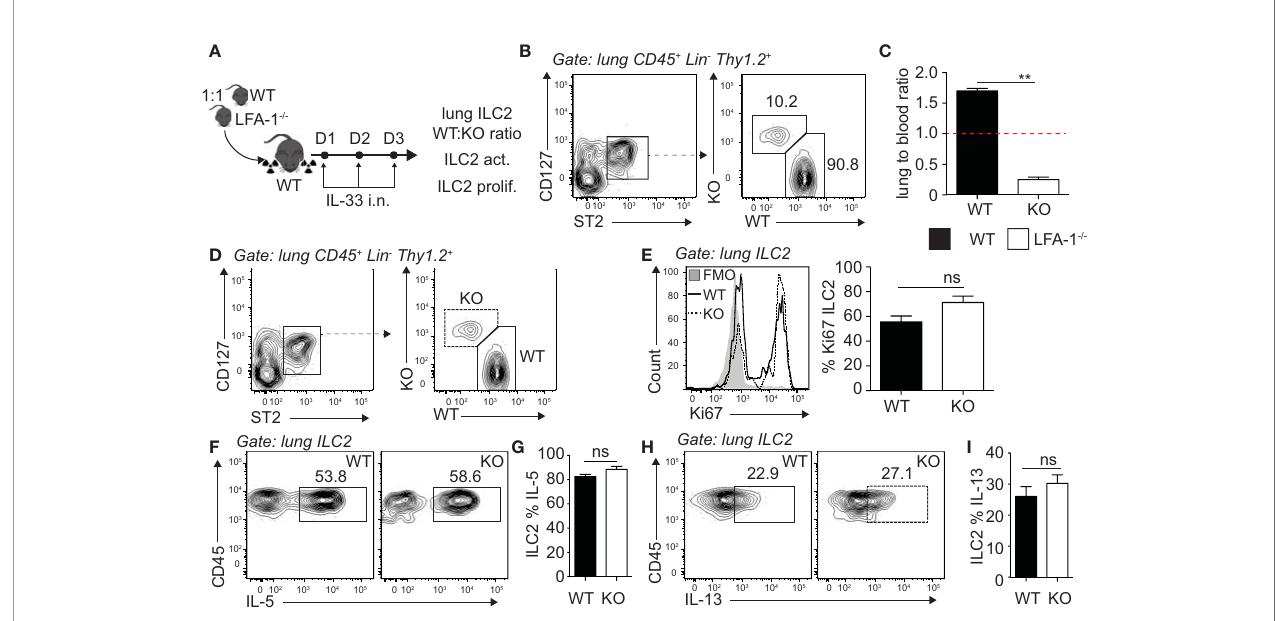
FIGURE 2 | LFA-1 on ILC2s is required for ILC2 accumulation in the lungs. (A) 5 × 10 6 1:1 mix of WT (CD45.1): LFA-1 − / − (CD45.2) bone marrow cells were intravenously injected through the tail-vein to lethally irradiated WT (CD45.1) host mice. 4 weeks after transfer, mice were challenged intranasally on days 1-3 with 0.5 µg rmIL-33. On day 4, lungs were recovered, processed to single cell suspensions and analyzed for the presence of pulmonary ILC2s (CD45 + Lin − Thy1.2 + ST2 + CD127 + ). We further measured the expression of CD45.1 (WT) or CD45.2 (LFA-1 − / − ) within total lung ILC2s by fl ow cytometry (B, C) , as well as the expression of Ki67 as a measure of proliferation (D, E) and intracellular IL-5 and IL-13 as a measure of activation (F – I) by fl ow cytometry in both CD45.1 (WT) and CD45.2 (LFA1 − / − ) pulmonary ILC2s. (B) Representative fl ow cytometry plots of total lung ILC2s expressing either CD45.1 (WT) or CD45.2 (LFA-1 − / − ) and (C) corresponding quantitation presented as the ratio of CD45.1 (WT) and CD45.2 (LFA-1 − / − ) ILC2s within total lung ILC2s, normalized to the peripheral blood CD45.1:CD45.2 ratio of each individual mice ± SEM. Red dotted line represents the ratio of 1. (D) Representative fl ow cytometry plots of CD45.1 + (WT) and CD45.2 + (LFA-1 − / − ) expression within total lung ILC2s. (E) Representative fl ow cytometry plots depicting the frequency of Ki67 expression within CD45.1 + and CD45.2 + lung ILC2 populations and corresponding quantitation presented as the mean frequency of Ki67 expression within CD45.1 + and CD45.2 + lung ILC2s ± SEM. (F – I) After processing to single cell suspension, lung cells were further stimulated with PMA, ionomycin and Brefeldin A for 4 h at 37°C prior staining for intracellular cytokine markers. Representative fl ow cytometry plots of IL-5 (F) and IL-13 (H) expression within CD45.1 + and CD45.2 + lung ILC2 populations and corresponding quantitation (G, I) presented as mean frequency of cytokine expression within CD45.1 + and CD45.2 + lung ILC2s ± SEM. Data are representative of 3 individual experiments with n = 5. **p < 0.005, ns, non-signi fi